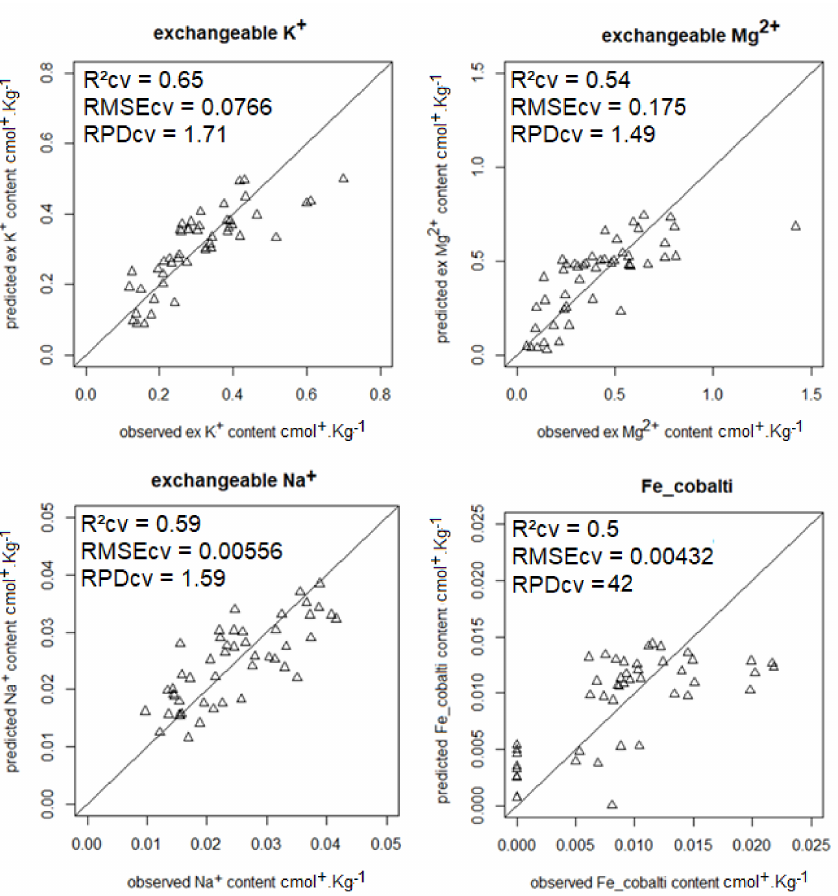
Figure 4. Scatterplots of predicted vs. observed exchangeable K + , Mg 2+ , Na + , and Fe (Fe_cobalti) contents from model